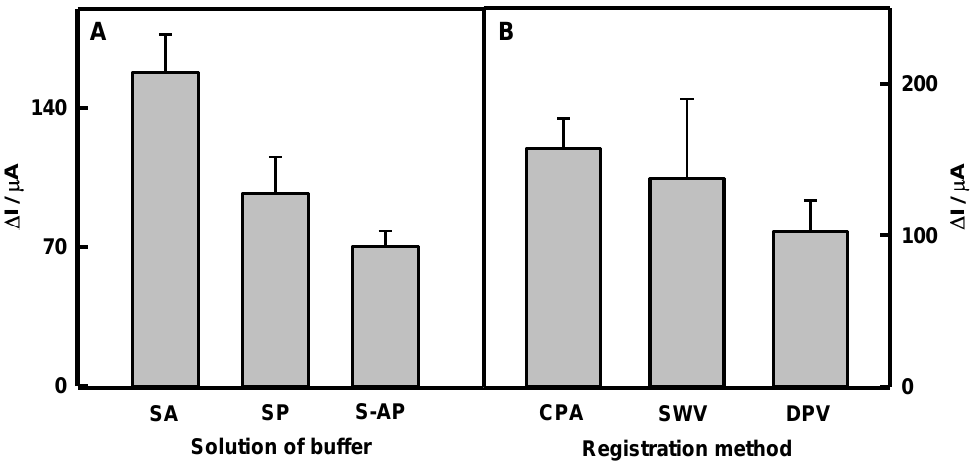
Figure 2. Diagrams of the current response registered ( A ) using the GOx/DGNs/GR electrode in different buffer solutions (pH 6.0) by the CPA method and ( B ) applying different electrochemical methods in SA buffer (pH 6.0). All measurements were performed in the presence of 6.0 mmol L −1 PMS and 27 mmol L −1 glucose; all buffer solutions contained 0.1 mol L −1 KCl.